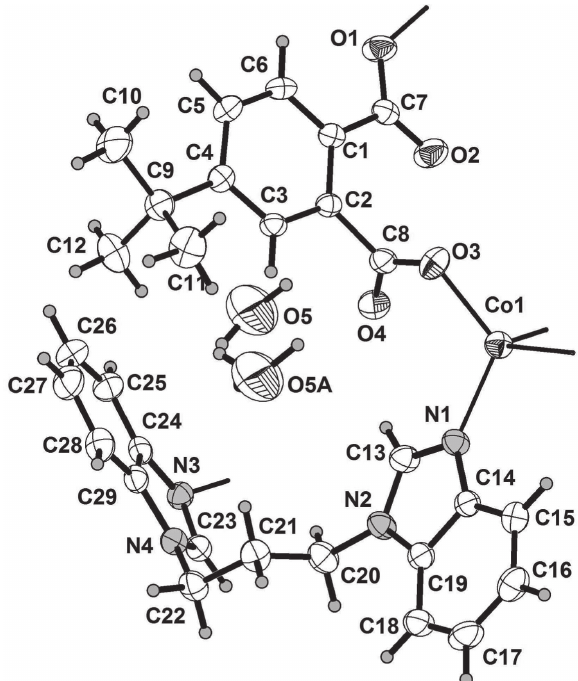
Table 1: Data collection and handling.